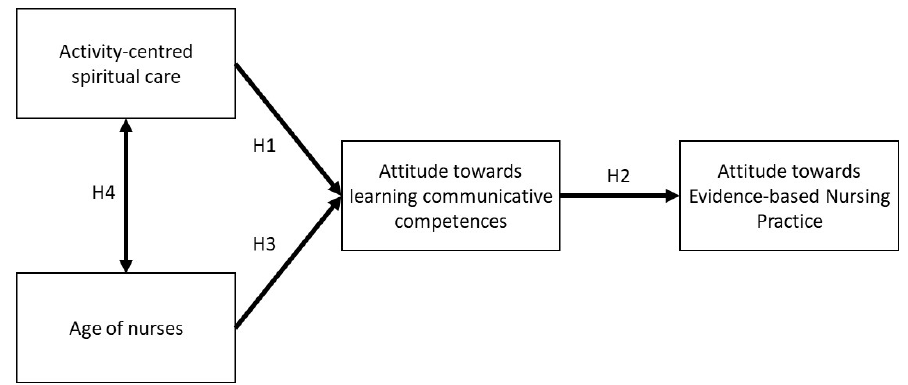
Figure 1. The theoretical model of the relationship between the tested variables (H—hypothesis).